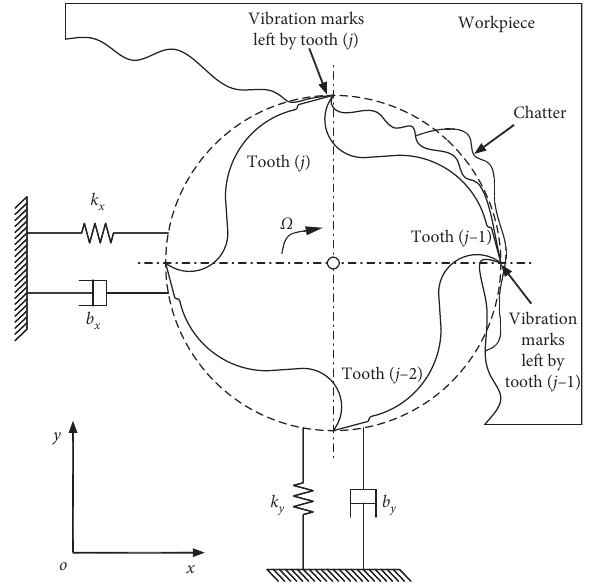
Figure 1: Dynamic model of end milling with two degrees of